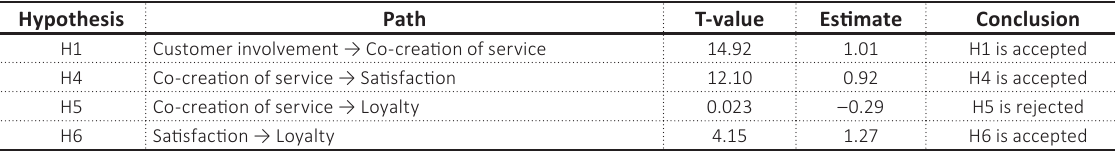
Table 3. Path coefficient direct effect